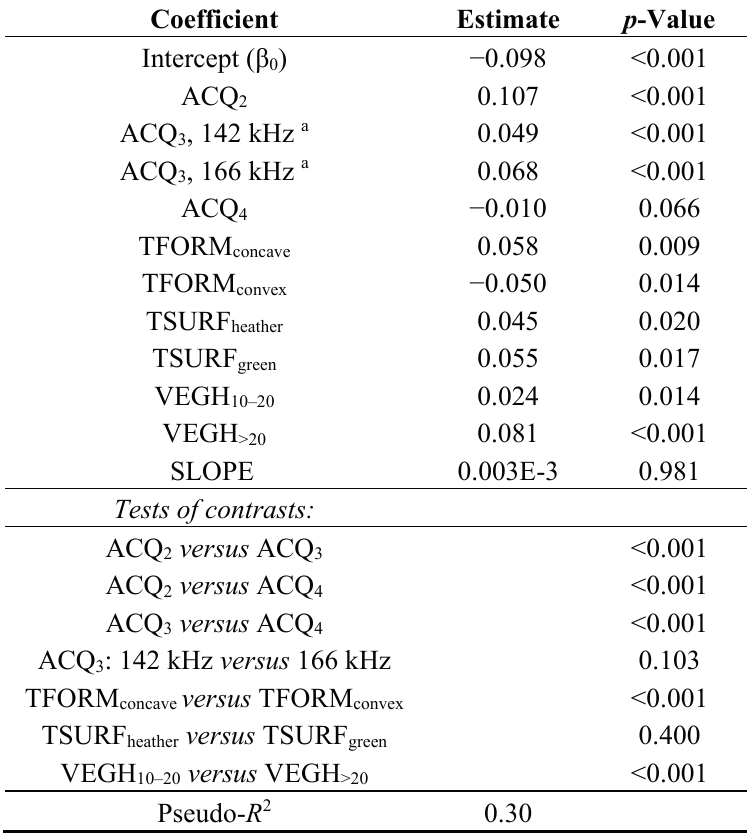
Table 5. Fixed effects and tests of contrasts in the regression analysis of the error in TIN surface elevation ( ε ) estimated according to Equation